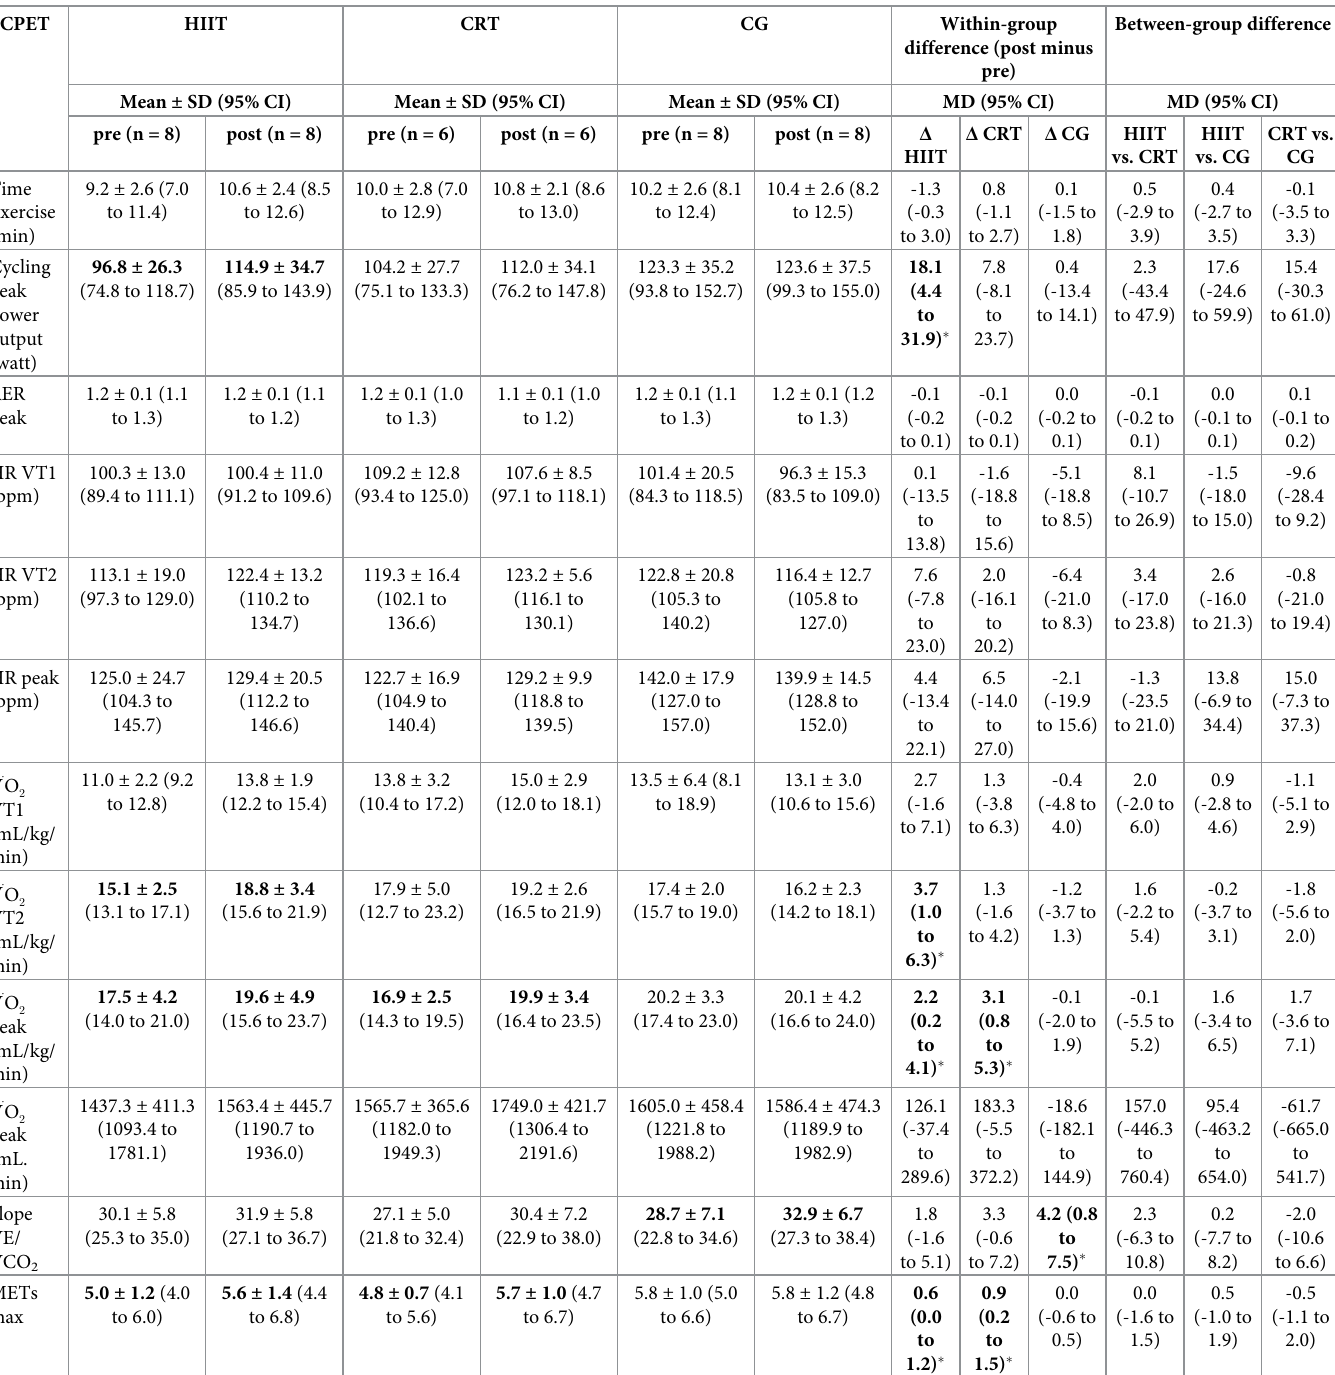
Between-group difference difference (post minus pre)